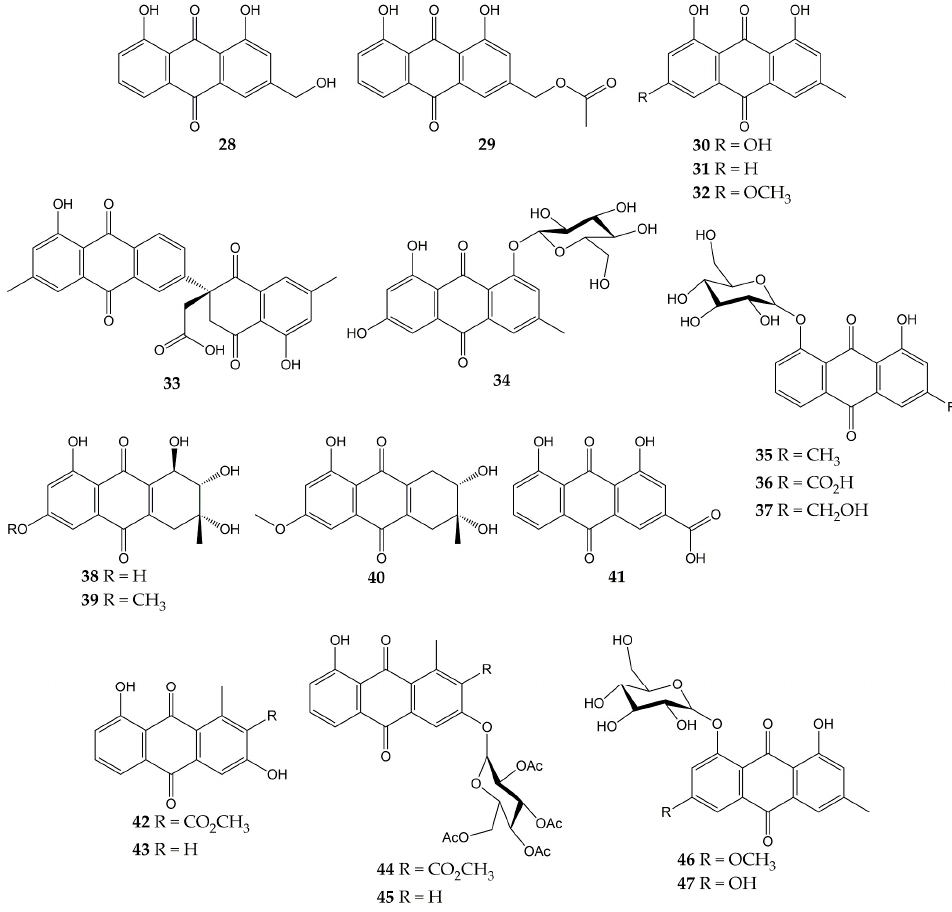
Figure 5. Chemical structures of natural and synthetic anthraquinones 28 – 47 .